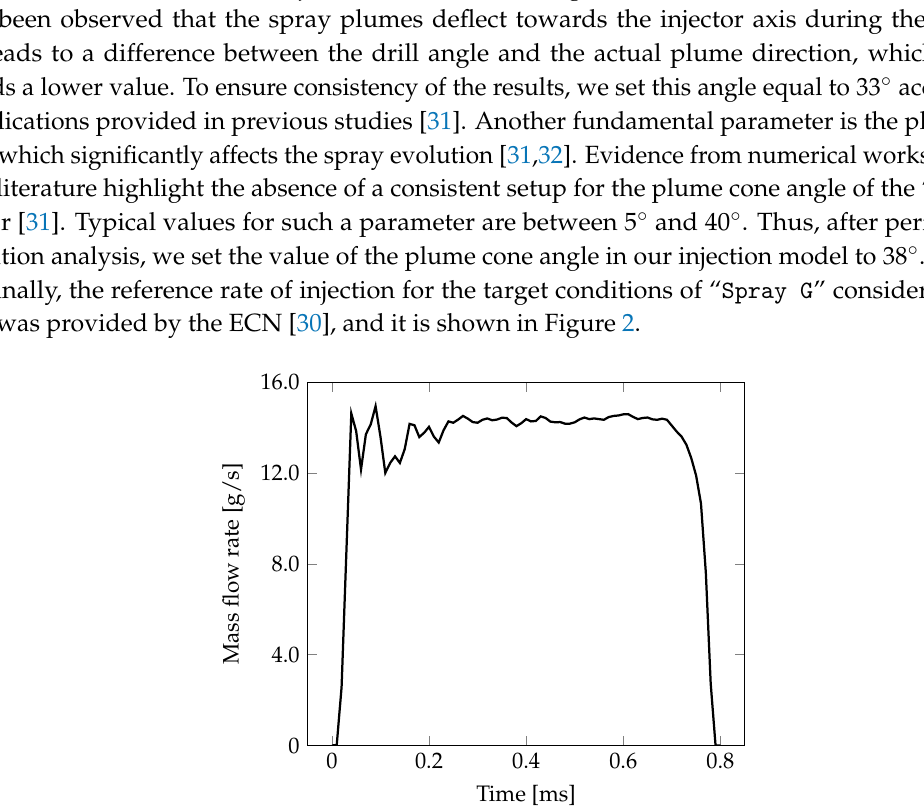
Figure 2. Rate of injection used as inflow condition in all